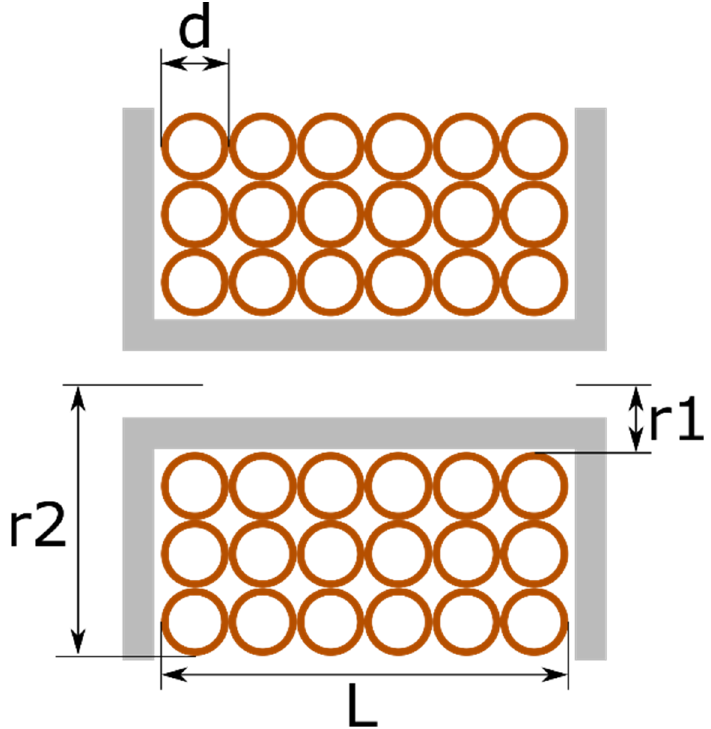
Figure 1. Structure of a multi-layer coil.